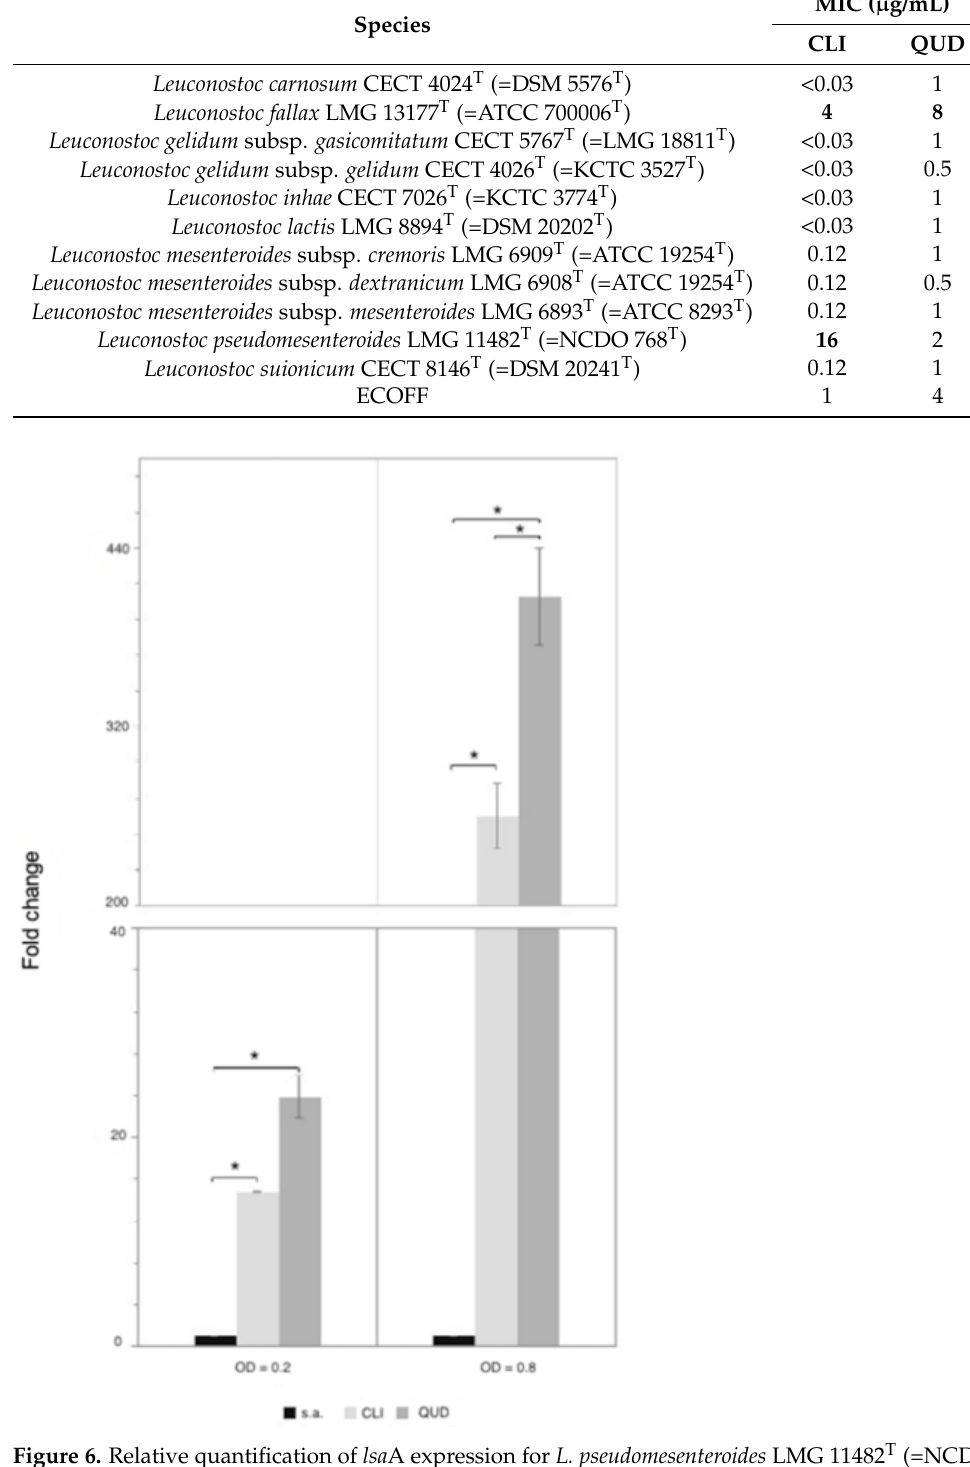
Figure 6. Relative quantification of lsa A expression for L. pseudomesenteroides LMG 11482 T (=NCDO 768 T ) grown in free-antibiotic culture (sa) in the presence of clindamycin 4 µ g/mL (CLI) or quinupristin-dalphopristin 1 µ g/mL (QUD). The cells were collected in the exponential and stationary growth phases 0.2 and 0.8 OD 600 , respectively. The expression of lsa A was normalized based on the expression of the 16S rRNA and calculated using the 2 − ∆∆ ct method. *: p -value <